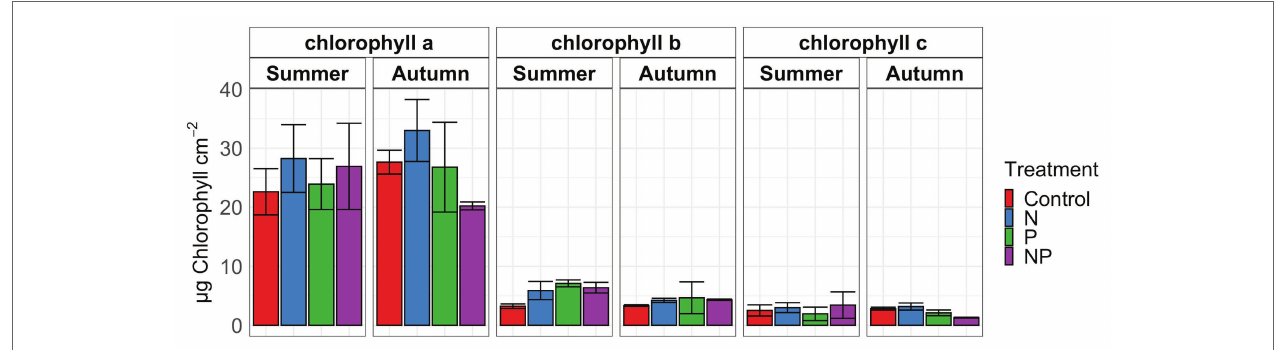
FIGURE 1 | Chlorophyll a , b , and c in periphyton for summer and autumn experiments of control, nitrate (N), phosphate (P) and nitrate + phosphate (NP) nutrient exposures. Bars represent average of triplicates. Error bars represent standard